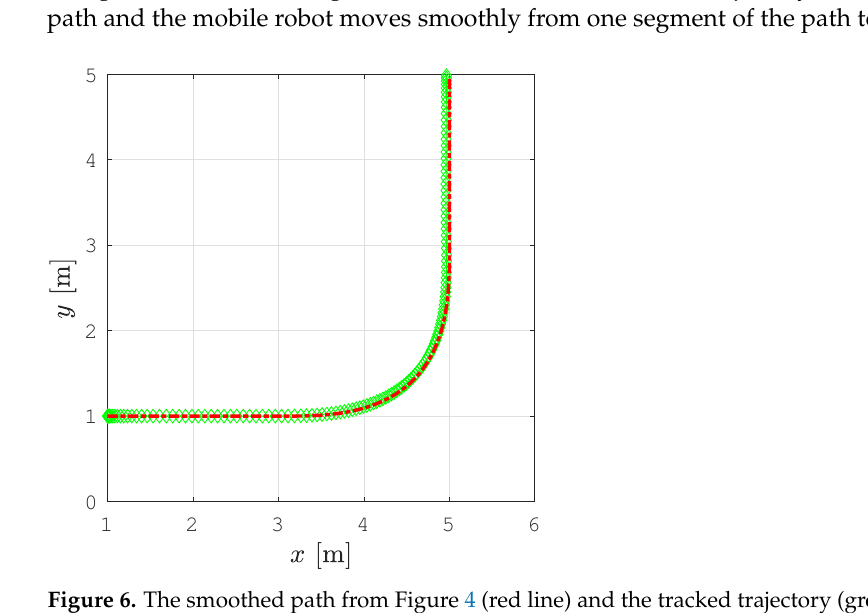
Figure 6. The smoothed path from Figure 4 (red line) and the tracked trajectory (green